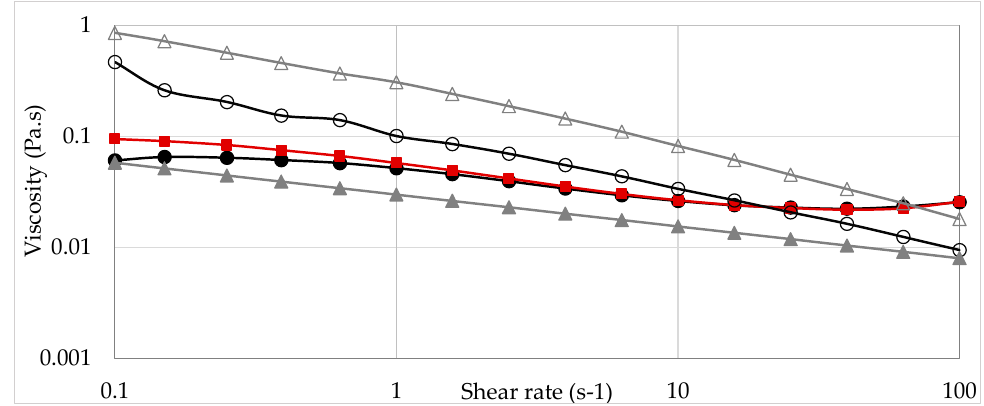
Figure 3. Viscosity of solutions with and without NaCl as a function of shear rate. HPAM solution in water (1000 ppm HPAM) ( Δ ); HPAM solution in brine (1000 ppm HPAM, 3 % NaCl) ( ▲ ); XG solution in water (1000 ppm XG) ( ); XG solution in brine (1000 ppm XG, 3 % NaCl) ( • ); Nanofluid (1000 ppm XG, 300 ppm NP-SiO 2 , 3 % NaCl) ( (cid:4)